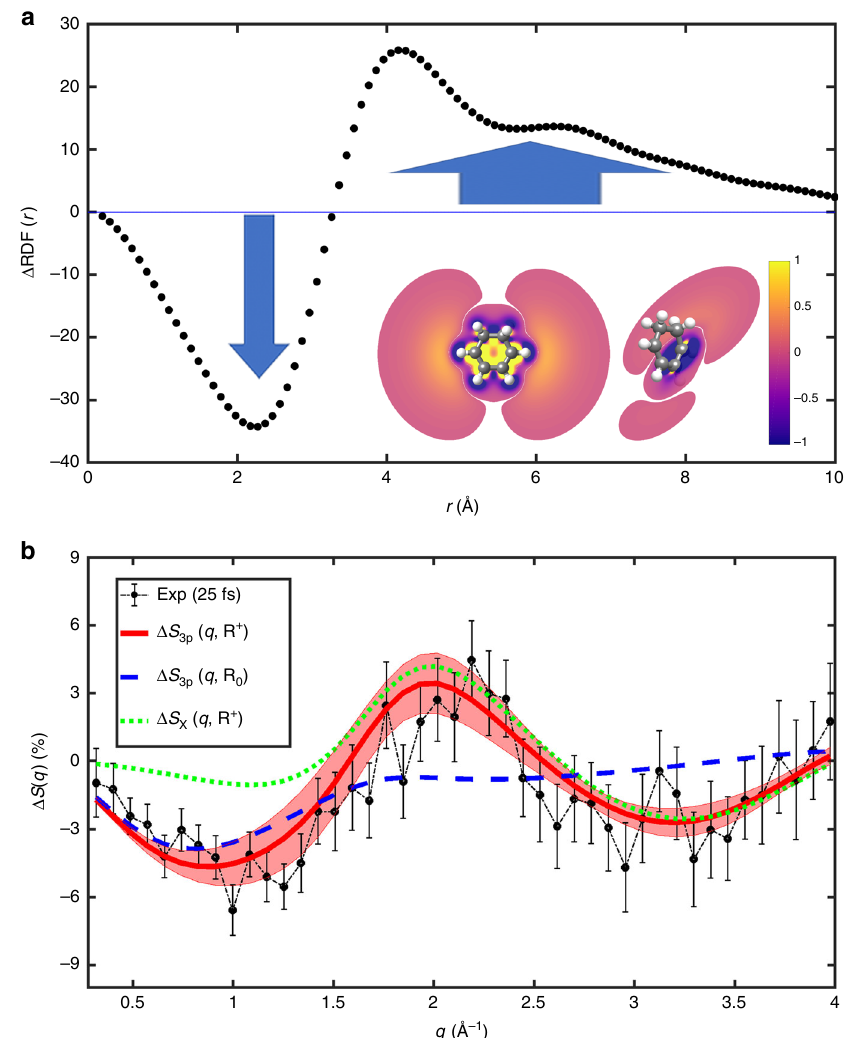
Fig. 2 Experimental and theoretical signals. a The real-space difference radial distribution function, Δ RDF ð r Þ , obtained from the experimental data at 25 fs pump – probe delay time. The blue arrows point to the depletion and increase in electron density at short and long electron distances, respectively, as the molecule is excited from the tightly bound ground electronic state to the diffuse excited 3p state. The insert shows the corresponding contour slices of the electron density difference from electronic structure calculations. The left-hand slice shows the difference in a plane through the C = C-C = C atoms, which illustrates the density gains far from the molecule, while the perpendicular right-hand slice, taken through one of the C = C bonds, shows the corresponding loss of density in the HOMO π -orbital. The color intensity is renormalized between − 1 and 1 and absolute values <0.01 are not shown. b Fractional difference signals, Δ S ð q Þ , shown in percent. The experimental signal at 25 fs delay time is shown in black with 1 σ error bars. The corresponding theoretical Δ S ð q ; R þ Þ signal for the electronic 3p state is shown in red with the shaded region accounting for the sampling of geometries in the excited state. For 3 p comparison, theoretical signals for the ground electronic state ( X ) at the 3p geometry, Δ S X ð q ; R þ Þ , and for the excited 3p state at equilibrium geometry, Δ S ð q ; R Þ , are 3 p 0